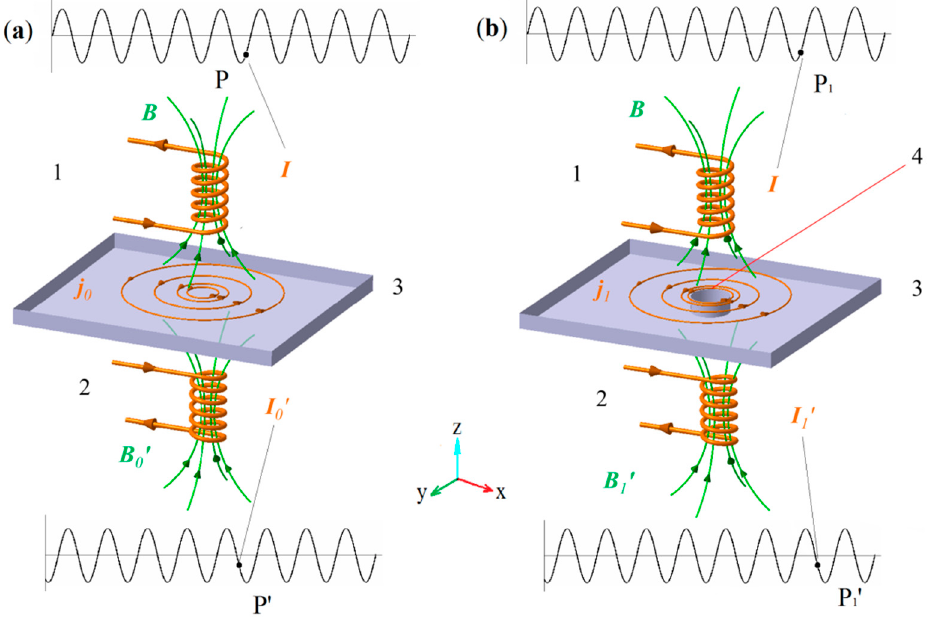
Figure 1. Principle of the traditional eddy current testing method: ( a ) without defects; ( b ) with defects. 1. Exciting coil; 2. Pick-up coil; 3. Copper plate; 4. Defect.